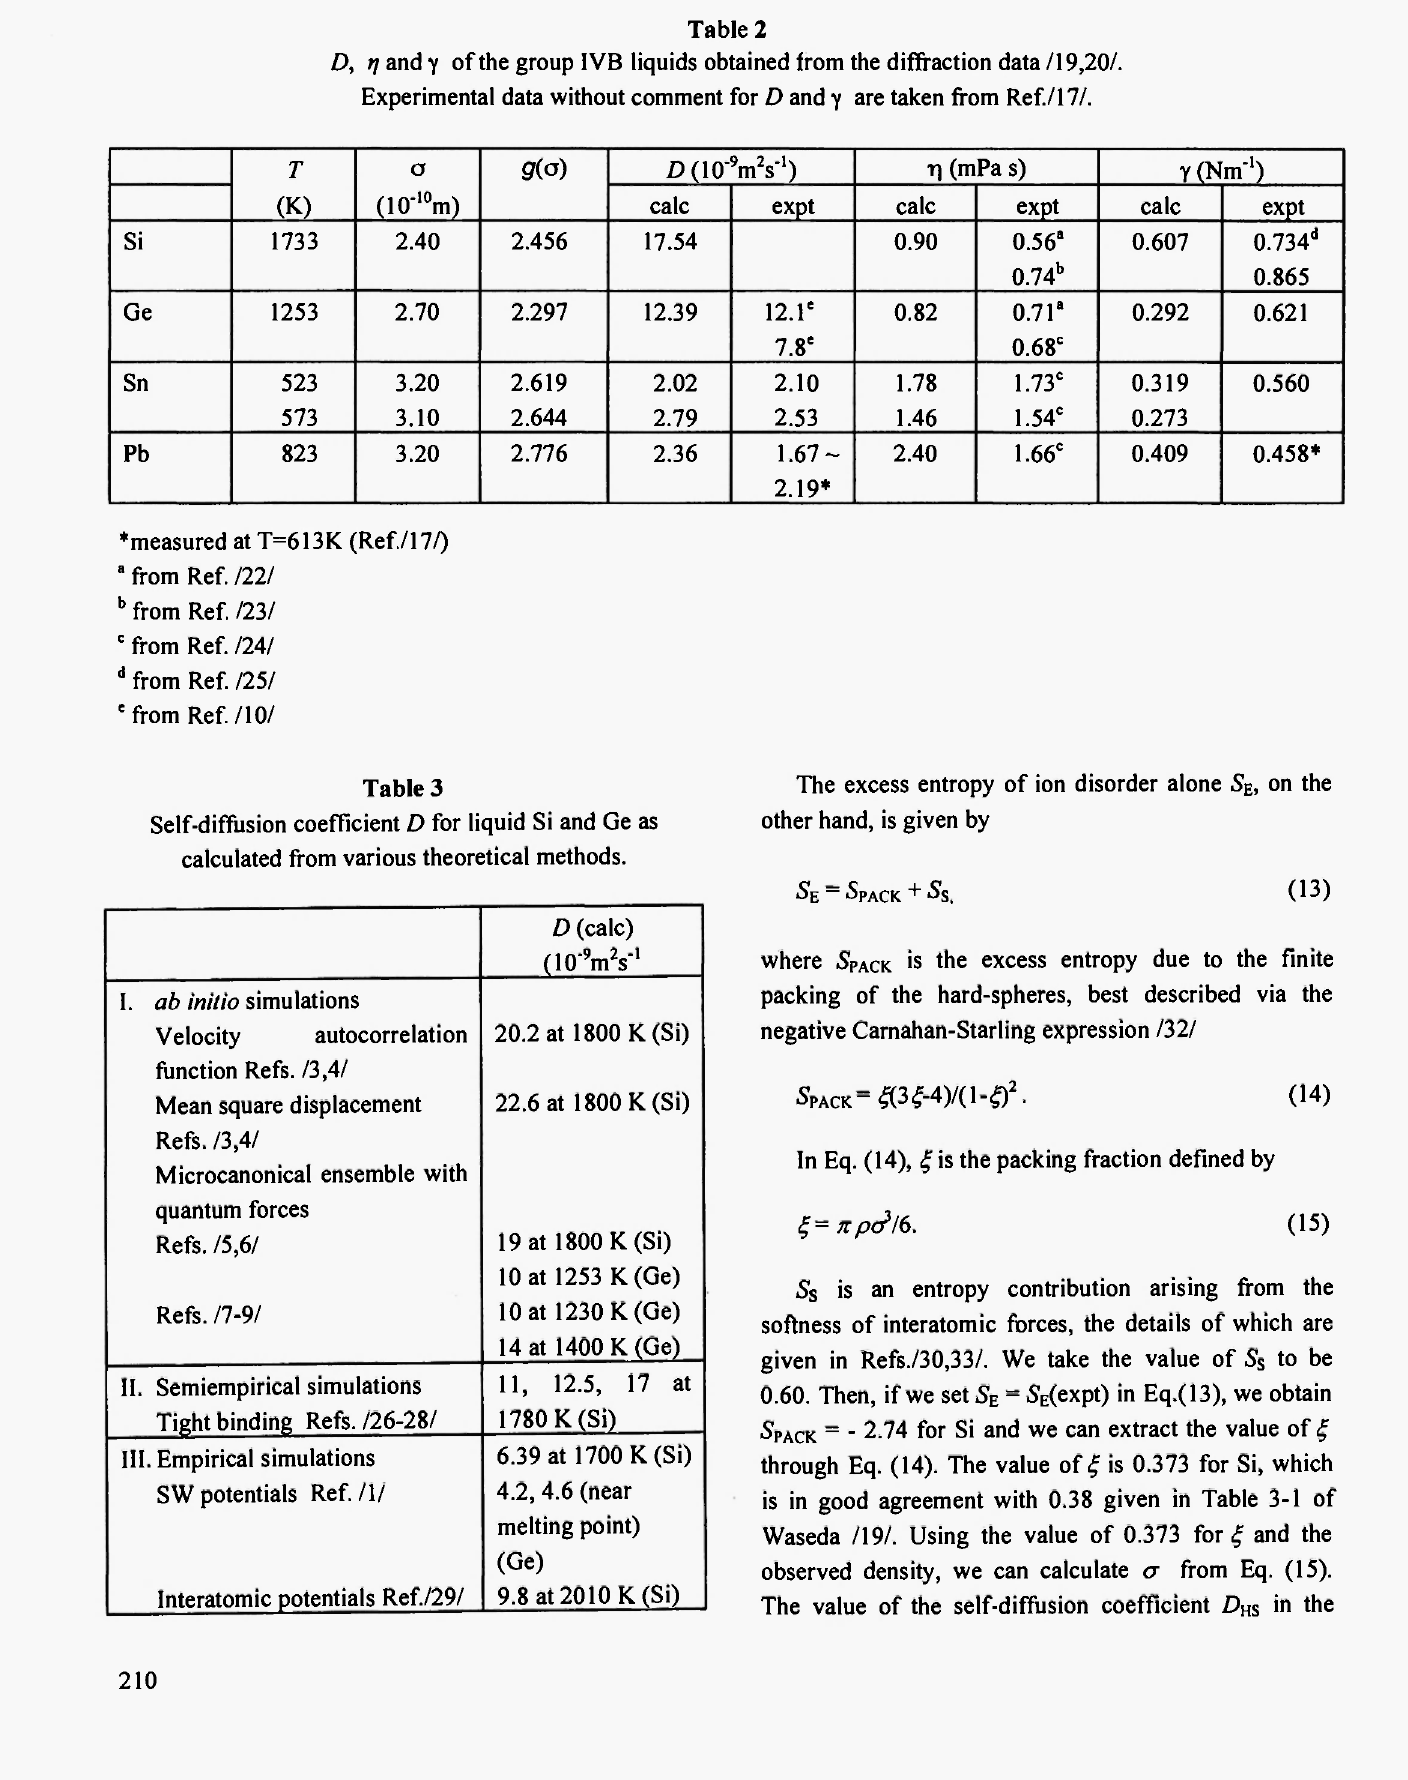
D, η and γ of the group IVB liquids obtained from the diffraction data /19,20/. Experimental data without comment for D and γ are taken from Ref./17/.